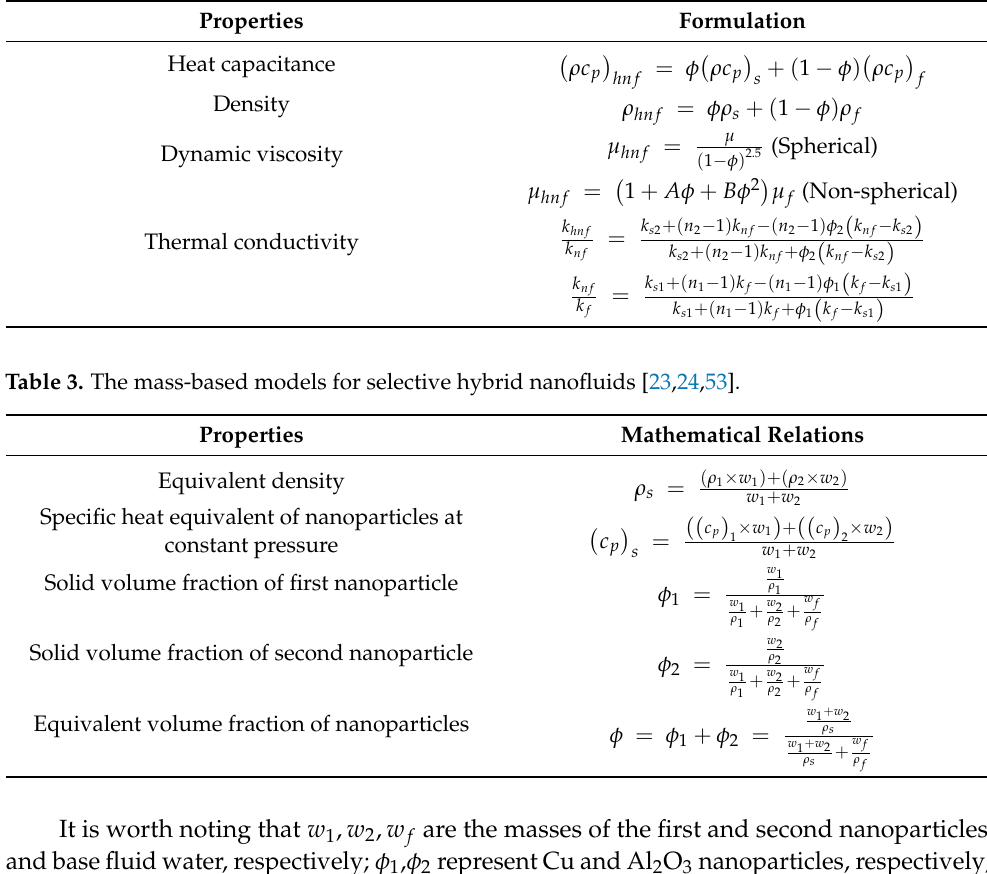
Table 2. Mass-based hybrid nanofluid models for thermophysical properties [23,24,53].